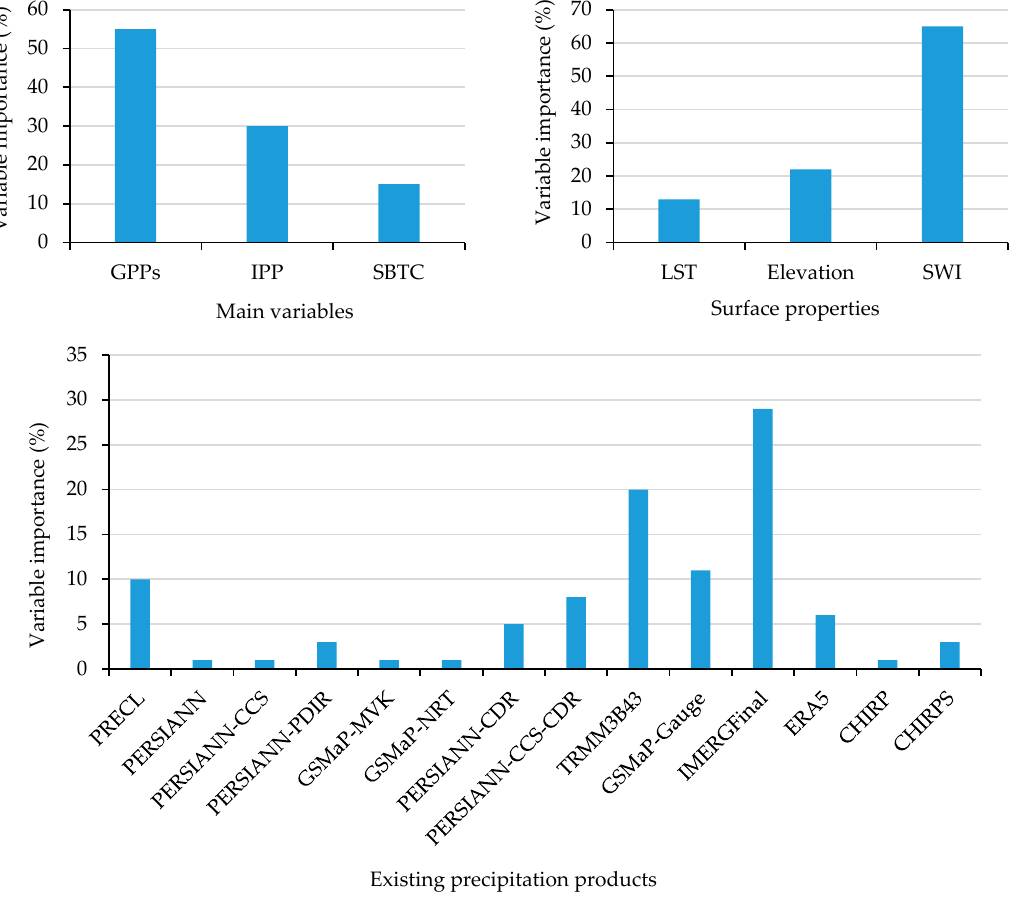
Figure 3. The importance degree of the independent variables in improving the accuracy of precipitation estimation.